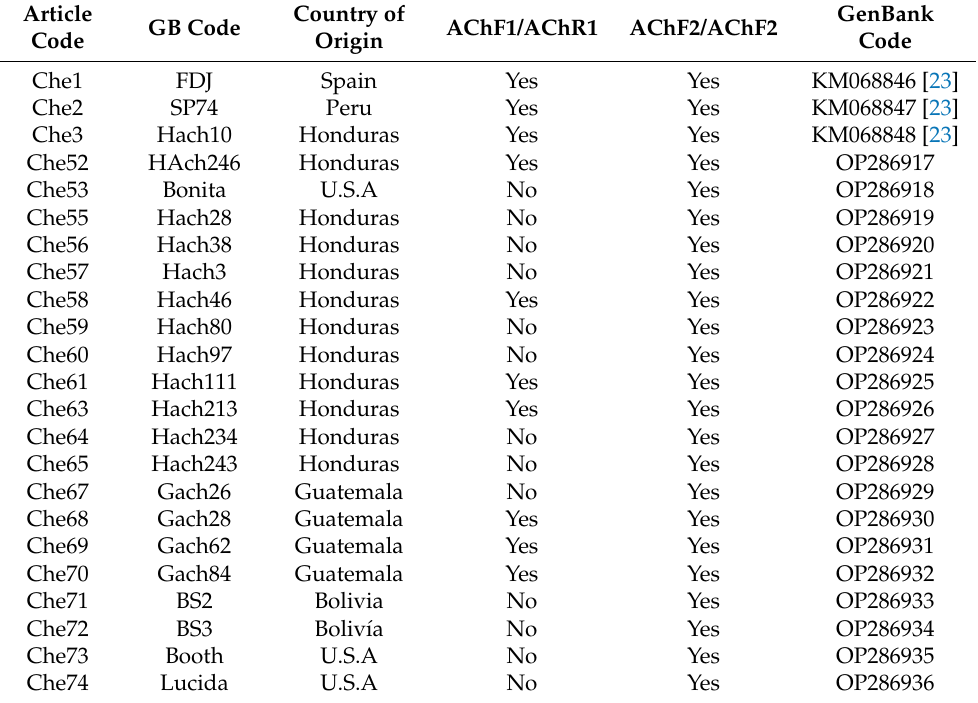
Table 3. Sequenced samples with mat K universal primers. The table shows the code utilized in this article, the germplasm bank code, whether they amplified with Achf1/AChR1 and AChF1/AChF2 primers, and GenBank codes.